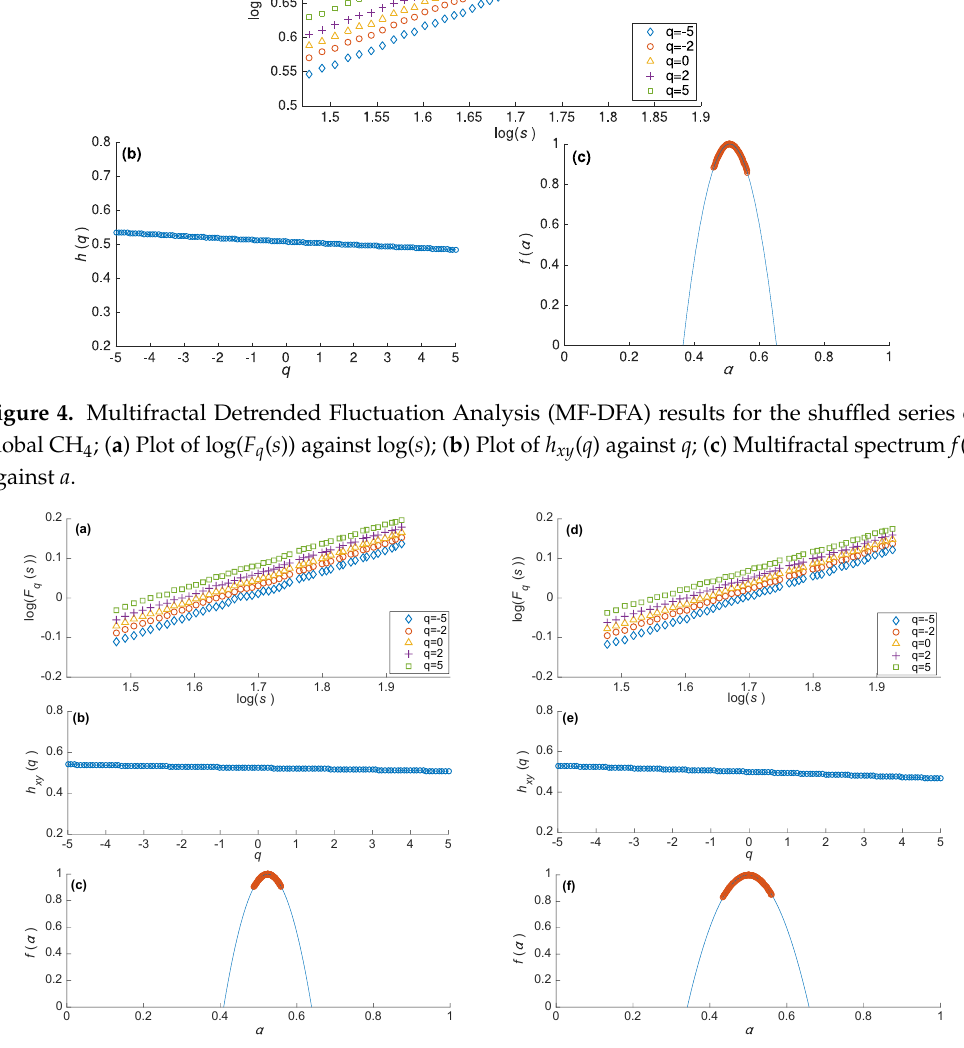
Figure 5. Multifractal Detrended Cross-Correlation Analysis ( MF-DCCA) plots for the shuffled series between global CH 4 and global LT (left) and MT (right) temperature anomalies; ( a , d ) Plot of log( F q ( s )) against log ( s ); ( b , e ) Plot of h xy ( q ) against q ; and, ( c , f ) Multifractal spectrum f ( a ) against a .